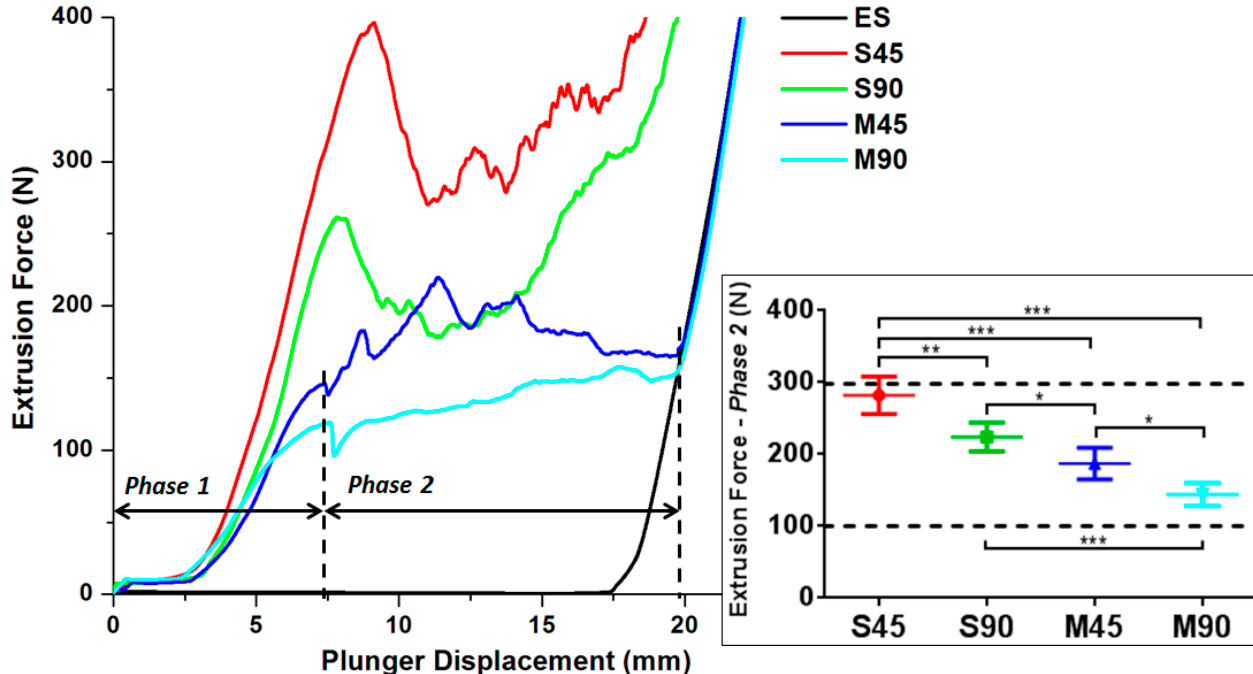
Figure 9. Effect of different mixing times and shear regime on extrusion force–plunger displacement profiles (ES: Empty syringe, S: Spatulated samples, M: Planetary-mixed samples, “45” or “90” refers to the correspondent mixing time, in seconds). Phase 1 profile includes several contributions, such as the plunger friction and the material compacting before paste extrusion. Phase 2 indicates the force profile during the extrusion of the material. Inset: Extrusion force calculated for each test, with the reported range for manual orthopedic surgeon injection in dotted line (*: p < 0.05, **: p < 0.01, ***: p < 0.001).